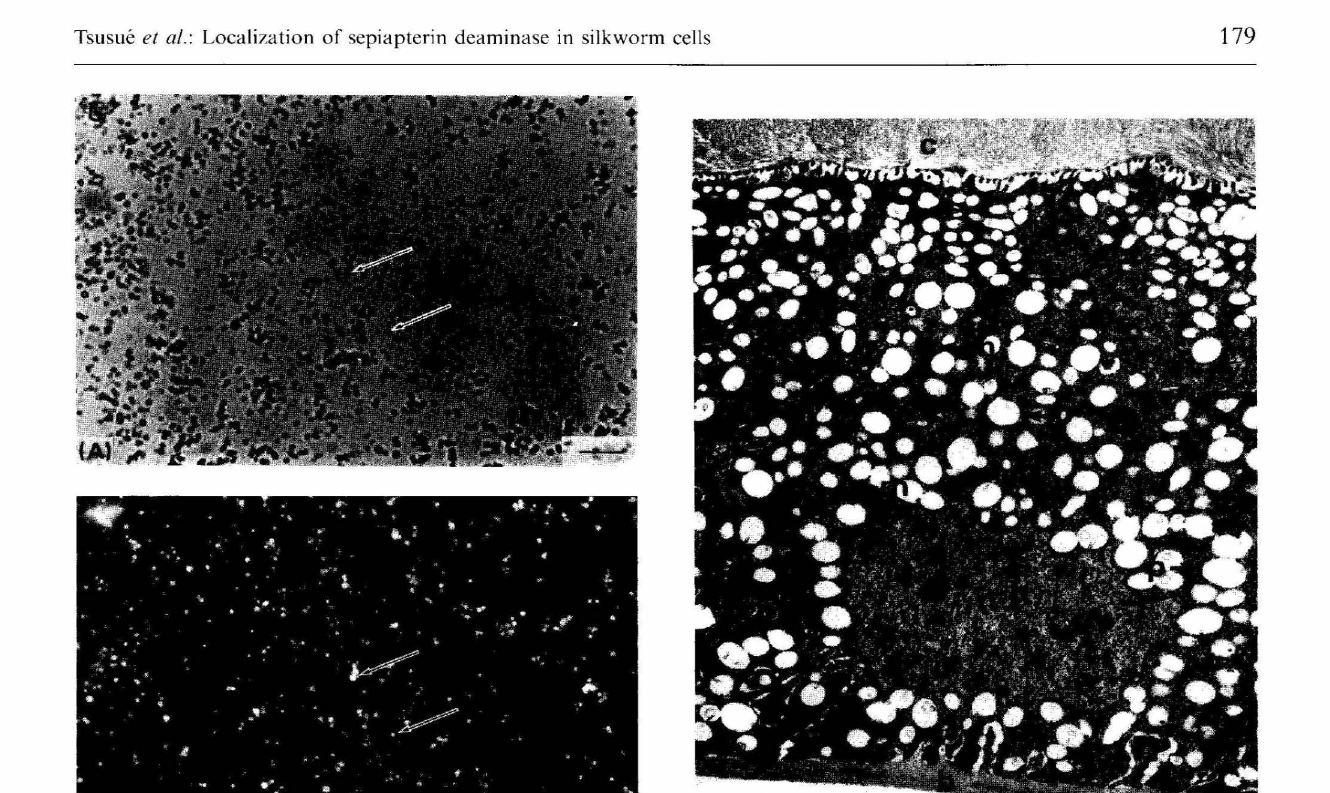
Figure 3. (A) Light microscopic photograph of epidermal cells. Scale shows 10 11m. Thc arrows show ptcridine granules. (B) Fluorescent microscopic photograph of the same cells as (A). Scale shows 10 11m. The arrows show pteridine granules.